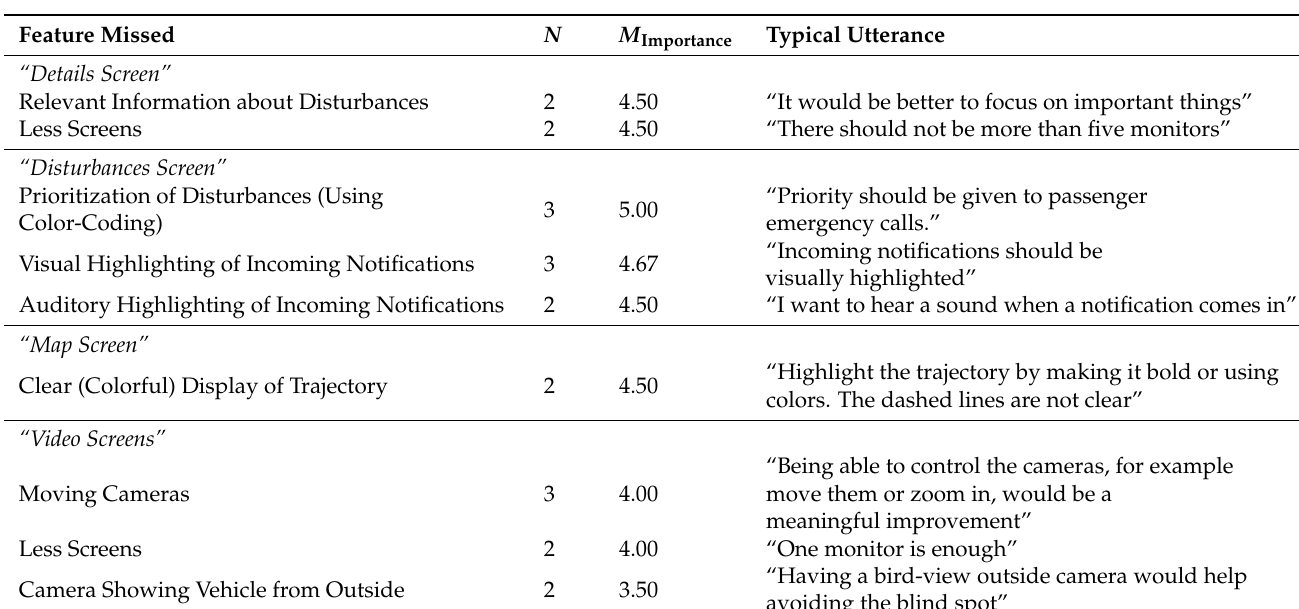
Table 4. Overview of features